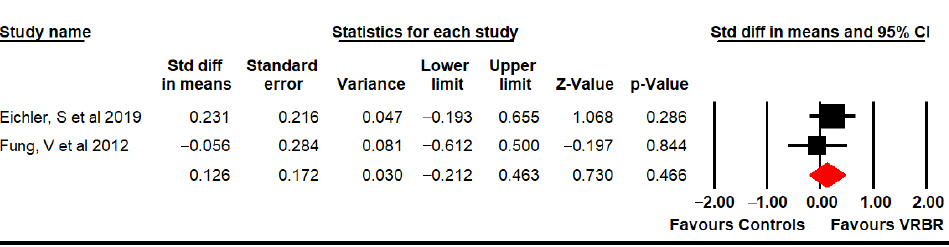
Figure 8. Forest plot of the immediate effect of VRBR on aerobic capacity [62,64].